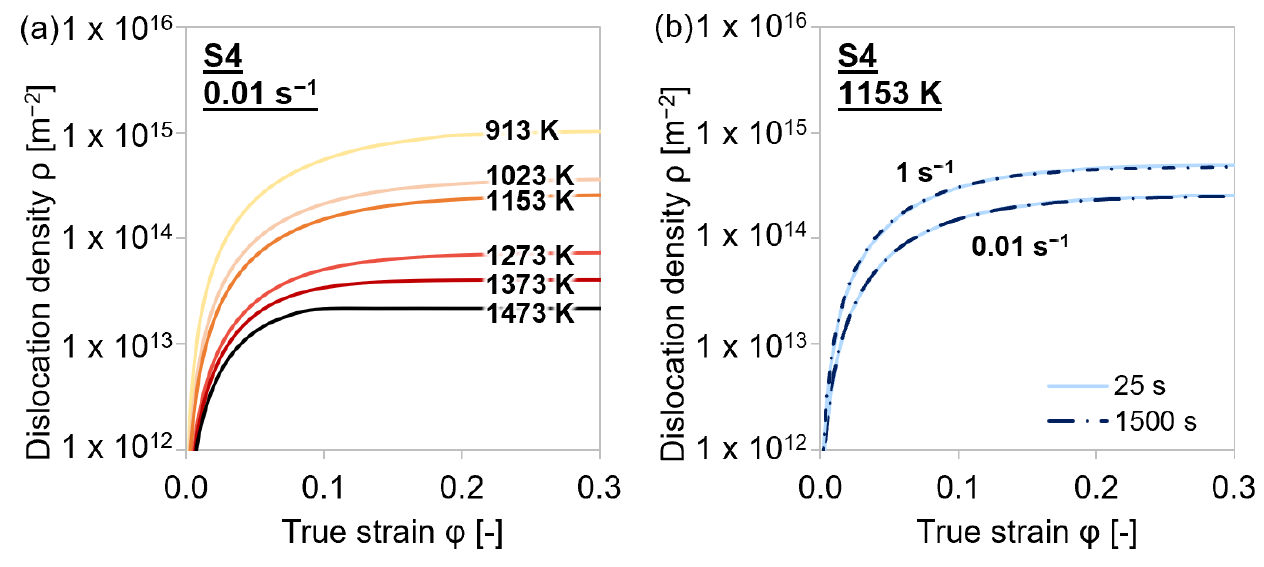
Figure 11. Simulation results of dislocation density evolution during single-hit compression tests with varying holding times before deformation, strain rates, and temperatures of MA steel grade S4. ( a ) 25 s, 0.01 s − 1 , 913–1473 K; ( b ) 25–1500 s, 0.01–1 s − 1 , 1153 K.